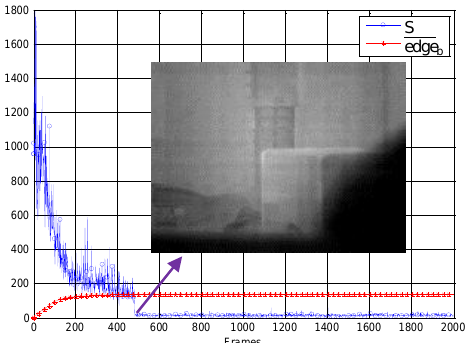
Figure 10. The variation of the important variables in our algorithm during the real nonuniformity data correction.